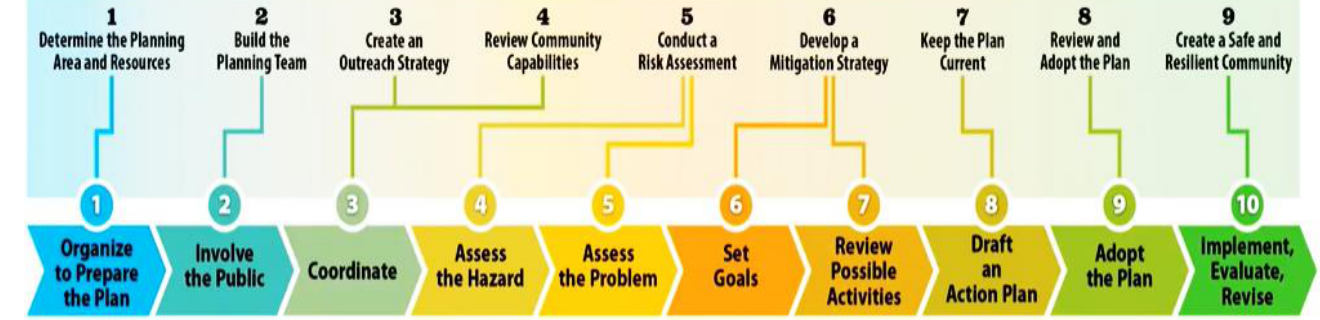
Figure 2. Implementation steps for strategies to mitigate WQ problems [2].